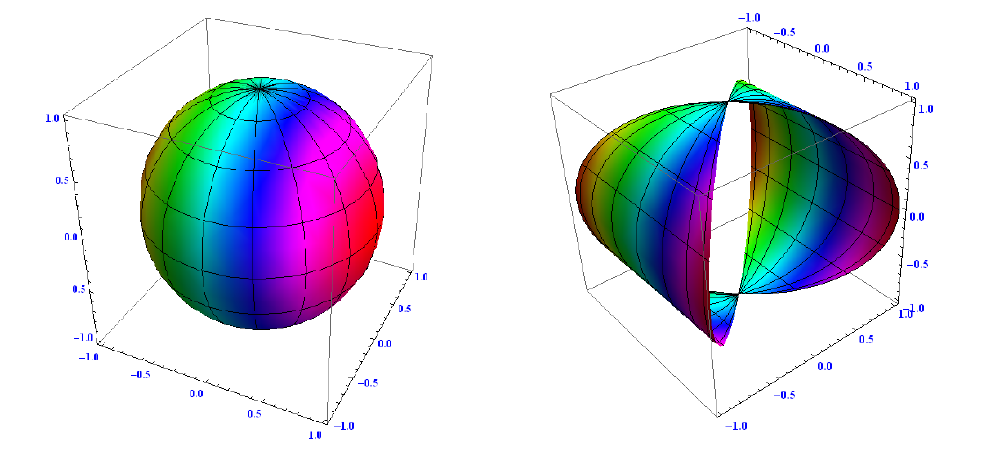
Figure 3. Projections of G of R into ( Left ) x 1 x 3 x 4 space, ( Right ) x 2 x 3 x 4